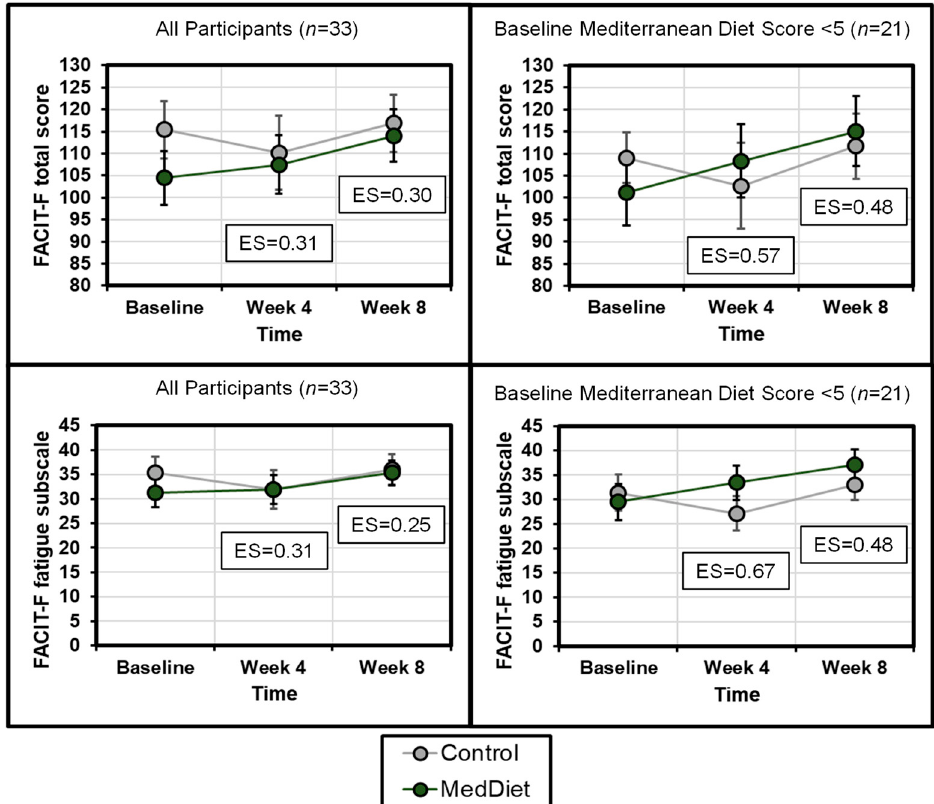
Figure 2. The Mediterranean Diet intervention was more effective for those with a lower Mediterranean Diet score at baseline. Cancer-related fatigue was measured using the Functional Assessment of Chronic Illness Therapy-Fatigue (FACIT-F) total score (top) and fatigue subscale (bottom). The left two panels show the effects of the intervention for all participants ( n = 33), and the right two panels show the effects of the intervention among those with a baseline Mediterranean Diet Score < 5 on the Mediterranean Diet Assessment Tool ( n = 21). For both the FACIT-F total score and FACIT-F fatigue subscale, a higher score indicates less fatigue. ES = effect size.